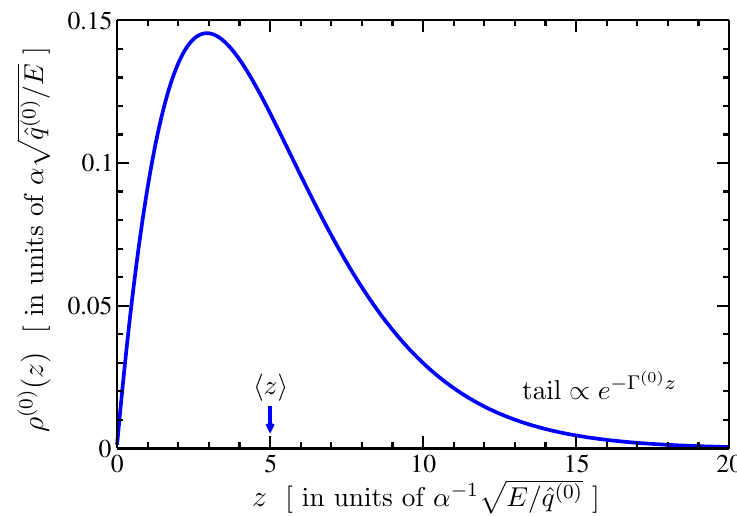
Figure 17 . The leading-order result for the distribution of charge deposition in large- N f QED. This calculation is made in the approximation of constant ^ q (0) , as discussed in section 2.2. The (cid:12)rst moment and width of the above curve is ‘ stop = 5 : 01 and (cid:27) = 3 : 24 [in units of (cid:11) (cid:0) 1 ( E= ^ q (0) ) 1 = 2 ], in agreement with results calculated using the recursion relation (2.10) with d (cid:0) (0) =d(cid:24)